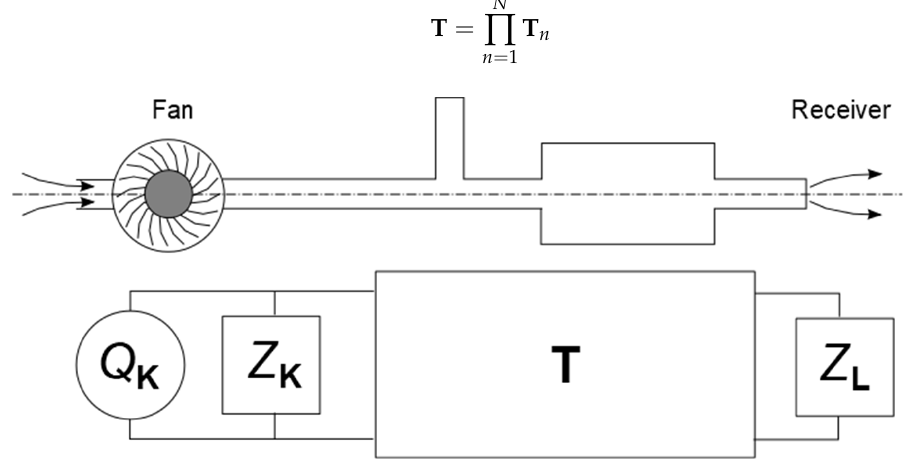
Figure 2. A ventilation system with silencer ( top ) and its linear acoustic system model ( bottom ). The fan is represented by its acoustic volume flow, Q K , and its acoustic impedance, Z K . The silencer system by its T-matrix, T, and the receiving room (load) with its acoustic impedance, Z L . The transmission loss of a silencer is a measure of the isolated silencer noise reduction capacity. It is a useful tool when a silencer component is tuned to a certain problematic frequency or frequency range. The insertion loss, on the other hand, also accounts for the system source and receiver impedances. Hence, it is ideal as a measure of the capability of a silencer to reduce the noise when it is installed in the